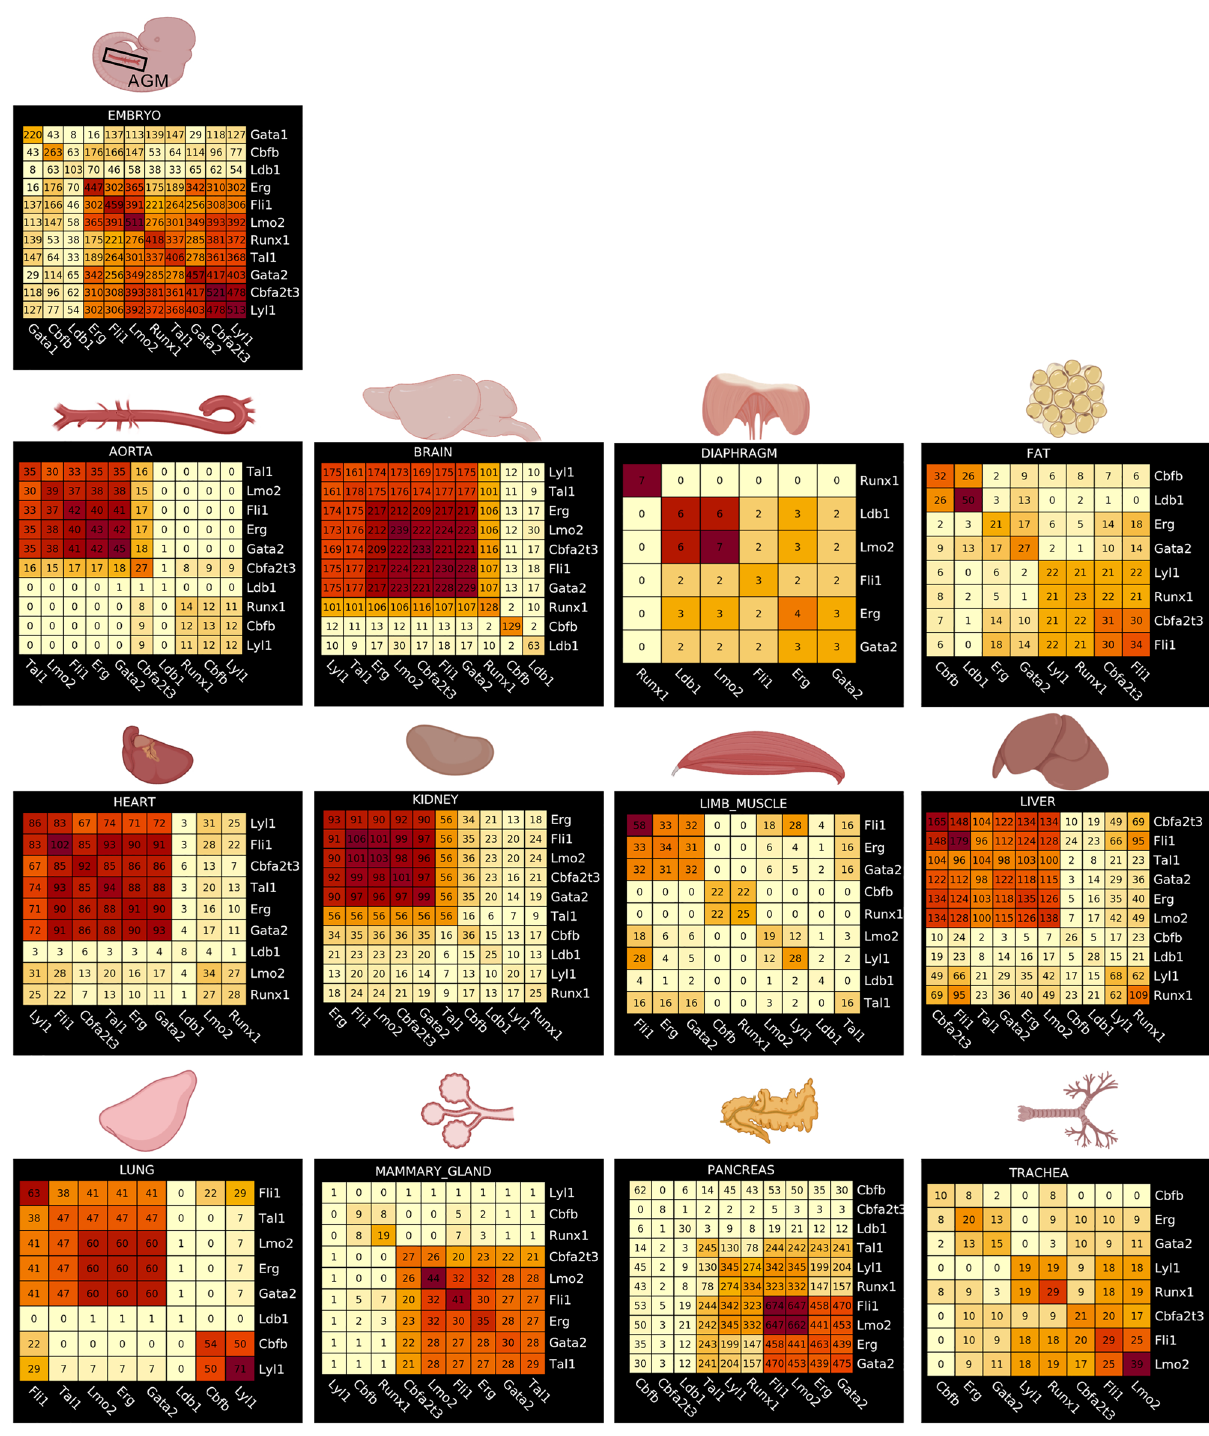
Figure 5. Identification of common target genes between the different seed transcription factors in each tissue. Heatmaps showing the result of a pairwise comparison of seed TF target genes in embryonic and adult tissues. Numbers in each heatmap correspond to the number of genes overlapping between two seed TFs. Figure was made in BioRender—https:// biore nder.